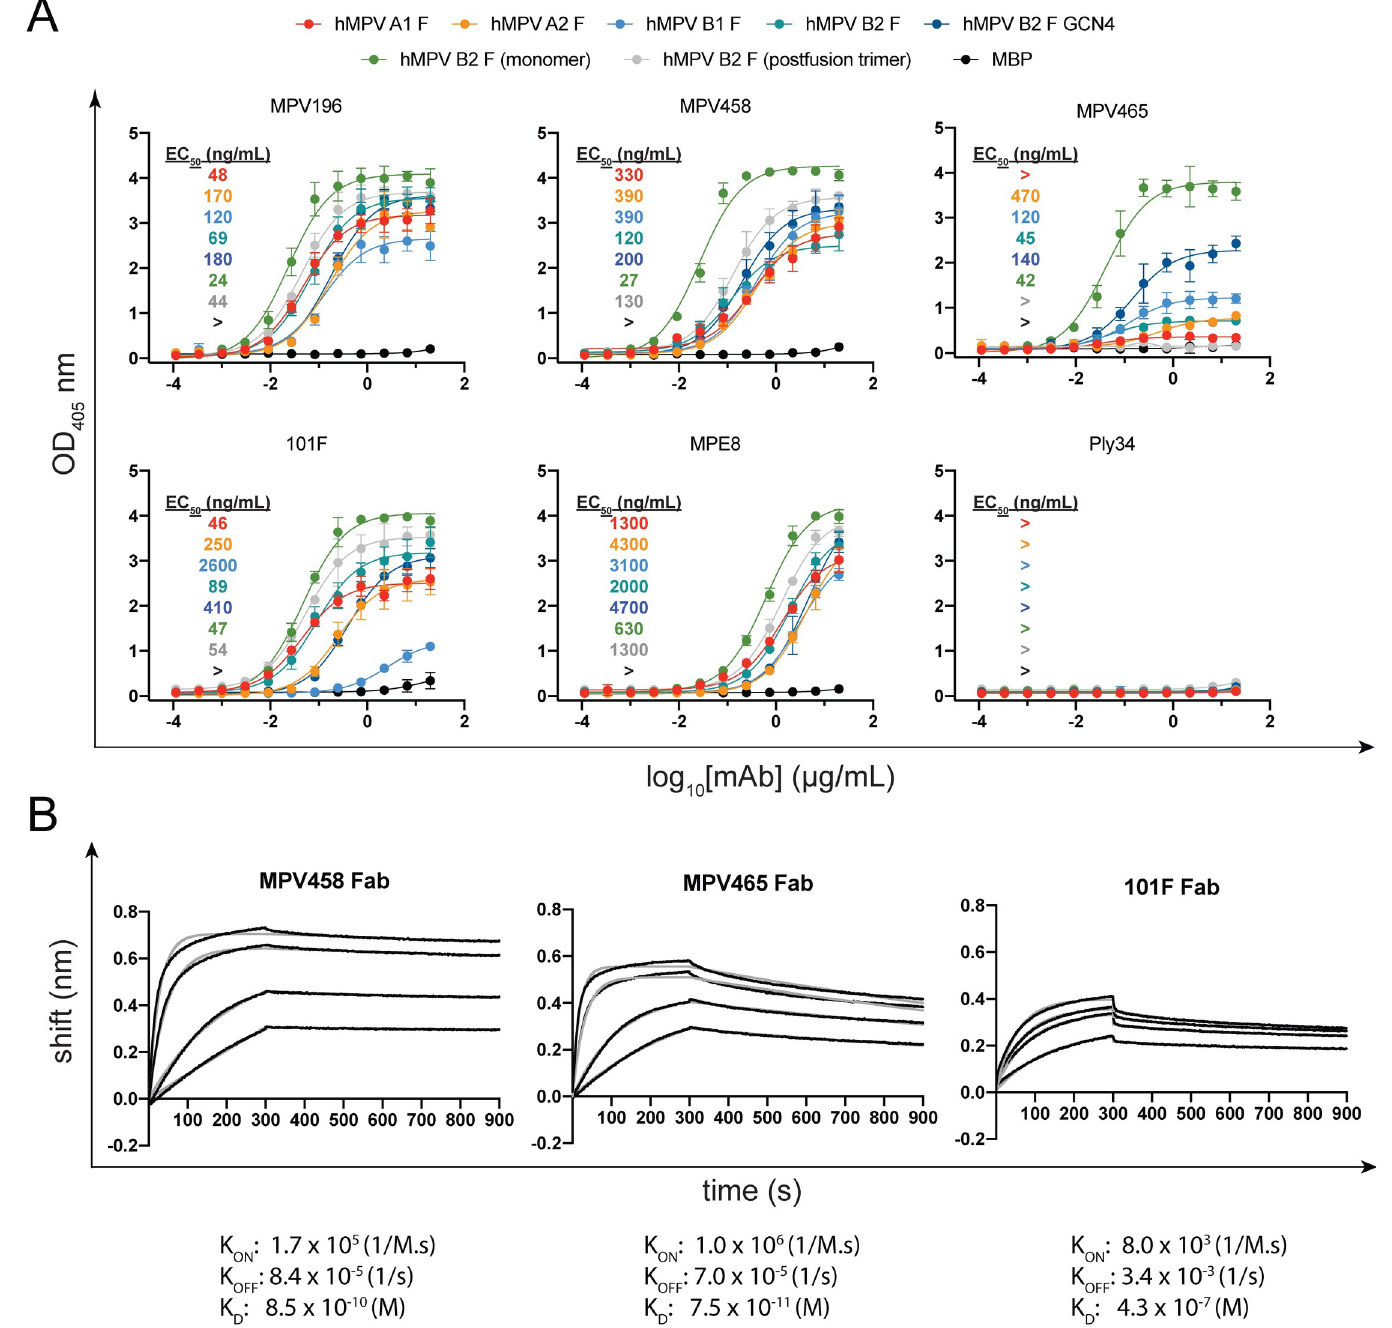
Fig 2. Binding measurements for MPV458, MPV465, and control mAbs. (A) ELISA binding curves for hMPV F-specific mAbs against a panel of hMPV F proteins including purified monomeric and trimeric hMPV B2 F protein that was treated with trypsin. Binding curves and EC 50 values are colored according to the legend. MPV458 and MPV465 have lower EC 50 values (higher affinity) for monomeric hMPV B2 F than trimeric hMPV B2 F. MPV458 and MPV465 bind to hMPV F proteins from all four subgroups. Data points are the average of four replicates and error bars are 95% confidence intervals. > indicates the calculated EC 50 was either not in the range of the curve (due to an overall low signal) or a signal above 0.5 absorbance units was not detected at the highest concentration of 20 μ g/mL. Each data point is the average of four replicates and error bars represent 95% confidence intervals. Data are representative of one experiment from two independent experiments. (B) Binding curves from biolayer interferometry. Biotinylated monomeric hMPV B2 F protein coated streptavidin biosensors were exposed to Fabs (MPV458 and MPV465: 10/5/1/ 0.5 μ g/mL, 101F: 100/75/50/25 μ g/mL) for 300 s before dissociating in buffer for 600 s. Binding constants are displayed underneath each graph and were averaged from the four